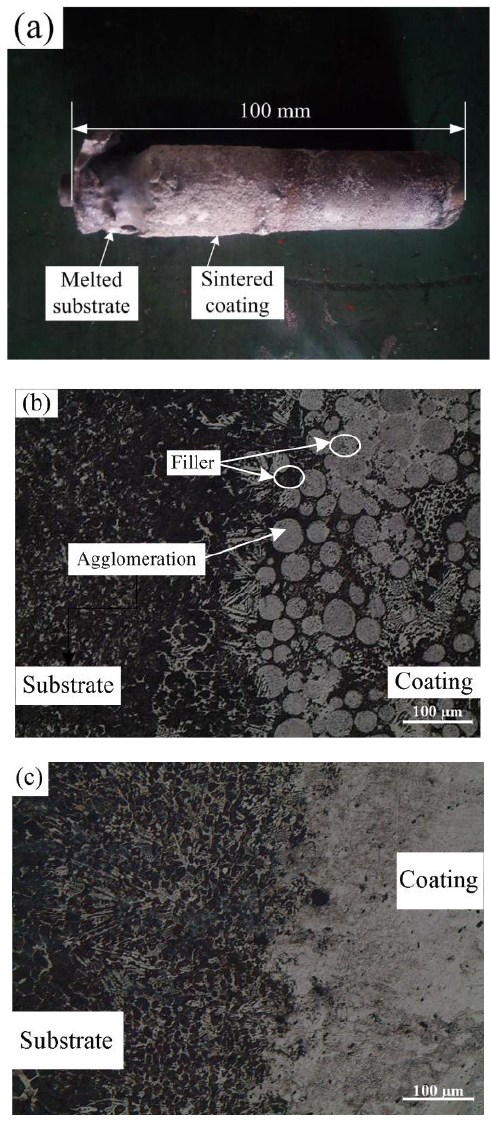
Figure 4. Photograph of sample Fe-1 ( a ) and morphology of Fe-2 ( b ) and Fe-3 ( c ).